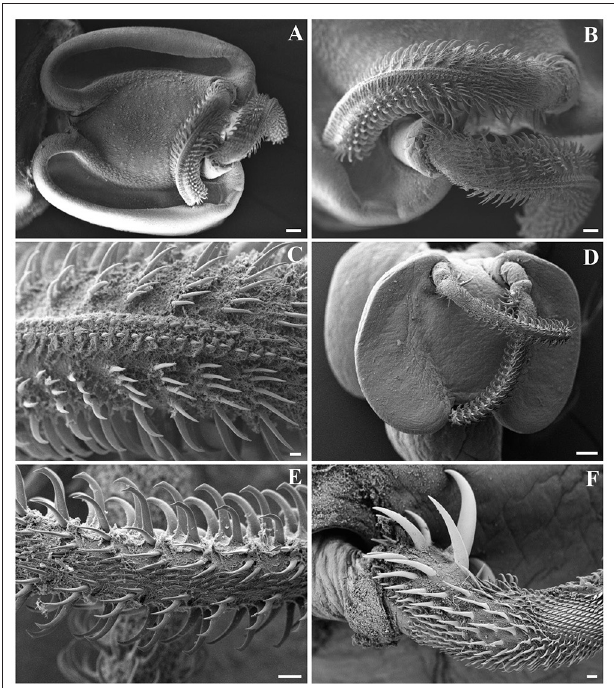
FIGURE 4 | Scanning electron micrographs of Gymnorhynchus gigas (A–C) and Molicola uncinatus (D–F) sequenced in the present study. (A,D) Bothria and tentacular apparatus. (B,C,E,F) Particular of tentacles. Note the presence of winged chainette elements on the external surface of metabasal armature of G. gigas (B,C) , and the beaklike tips of principal hooks and the band of spiniform hooks on the external surface of metabasal armature of M. uncinatus (E) . (F) Basal armature of tentacle of M. uncinatus .